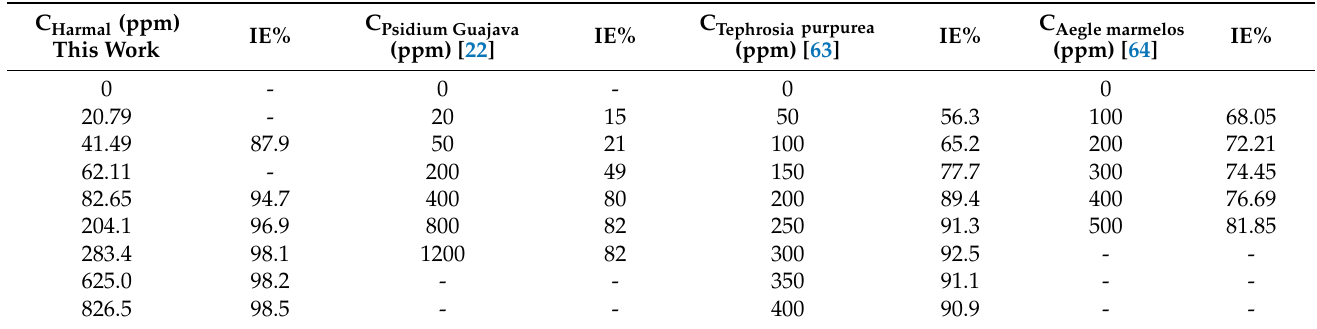
Table 5. Percent inhibition efficiency (IE%) toward C-steel corrosion by extract of Harmal, Psidium Guajava, Tephrosia purpurea and Aegle marmelos leaves at various concentration C